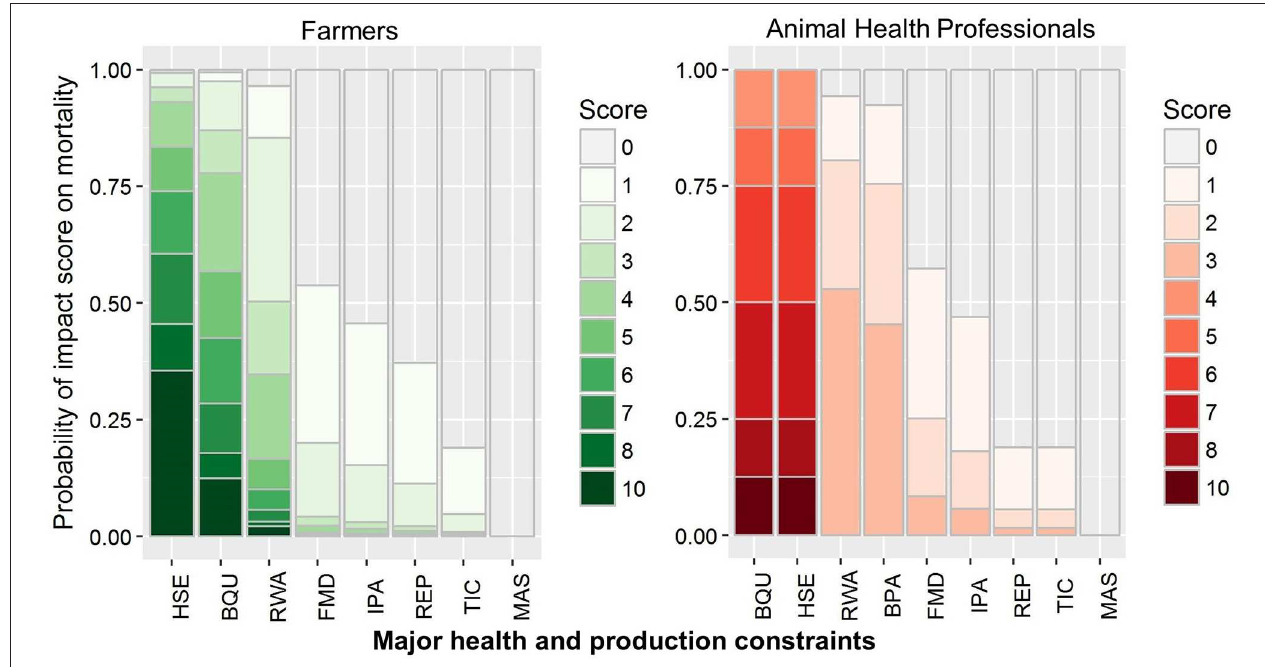
FIGURE 5 | Grouped stacked bar plot of logistic regression of probability impact score on mortality caused by health and production constraints in cattle and buffaloes perceived by small-scale dairy farmers and animal health professionals in Pakistan. Major bovine health and production constraints include blood parasites (BPA), blackleg (BQU), foot-and-mouth disease (FMD), hemorrhagic septicemia (HSE), internal parasites (IPA), mastitis (MAS), Redwater (RWA), reproductive disorders (REP), and ticks